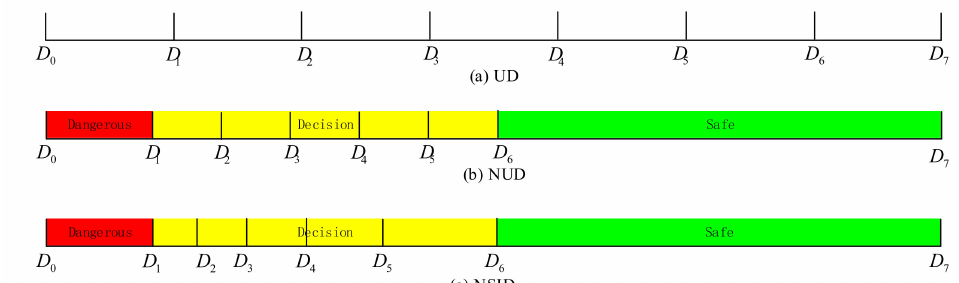
Figure 1. Discretization strategy diagram. ( a ) Uniform discretization (UD) [30]. ( b ) Non-uniform discretization (NUD). ( c ) Non-uniform spacing-increasing discretization (NSID) discretizing the depth interval [ D 0 , D 7 ] into seven